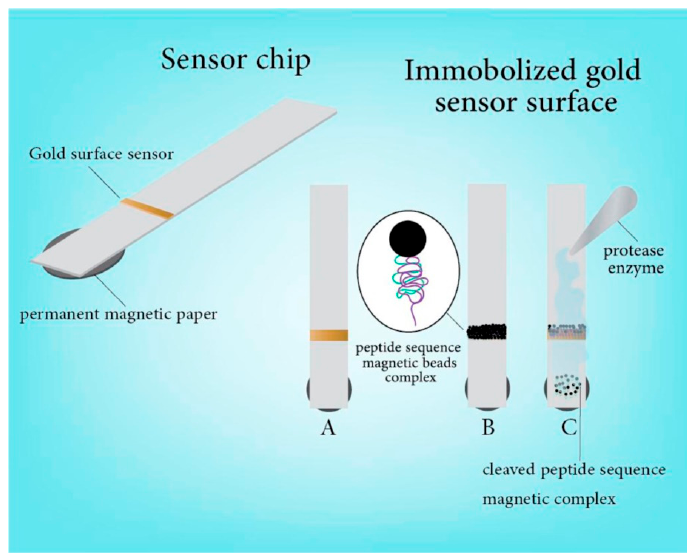
Figure 16. Listeria biosensor using modified magnetic NP. ( A ) gold sputtered on paper (yellow) over a plastic strip with a magnet underneath to remove unbounded magnetic NPs after immobilization; ( B ) magnetic NPs with immobilized peptide sequence placed over the gold surface to mask the color; ( C ) Adding protease enzyme of L. monocytogenesis will cleave the peptide from the NPs resulting in dissociation of the magnetic beads complex, exposing the gold surface (adapted with permission from [128]).